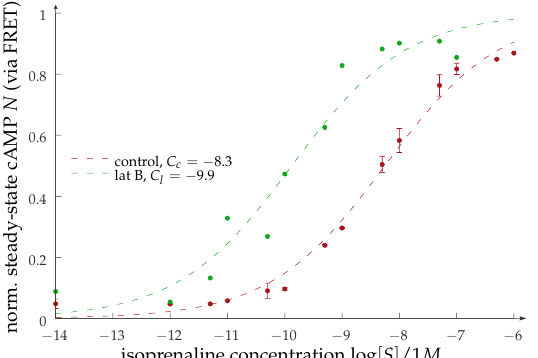
Figure 7. Pilot experiment displaying the dose–response curves for cells stably expressing a FRET cAMP biosensor (Epac1-camps(H187)) and exposed to actin depolymerization. Depicted is the steady state response to an external increasing isoprenaline concentration. The control curve corresponds to two measurements with untreated cells, while the LatB curve is the response with additional LatB (25 nM) and thus a lesser degree of polymerization in the actin. Lower connectivity in the mesh should reduce the dynamical inhibition of the receptors and therefore increase their mobility. The normalization and the fits are performed using a Hill–Langmuir function with n = 1. The numerical values for the constant C (in M) are given in the plot and quantify the obvious left shift upon the addition of LatB that is qualitatively in line with the reasoning for an increase in